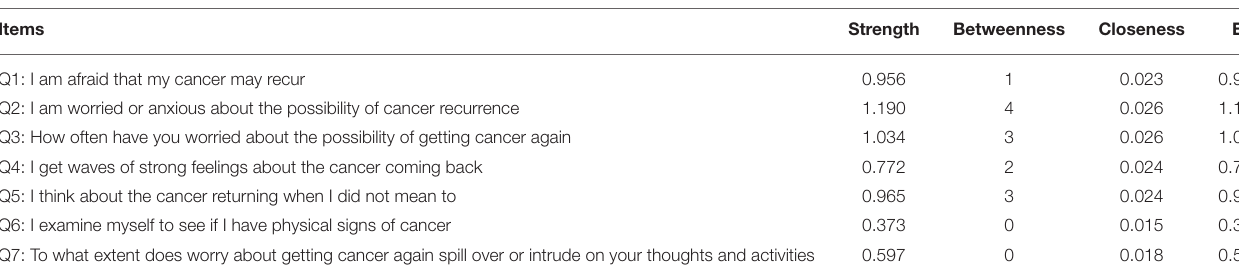
TABLE 2 | Centrality of FCR